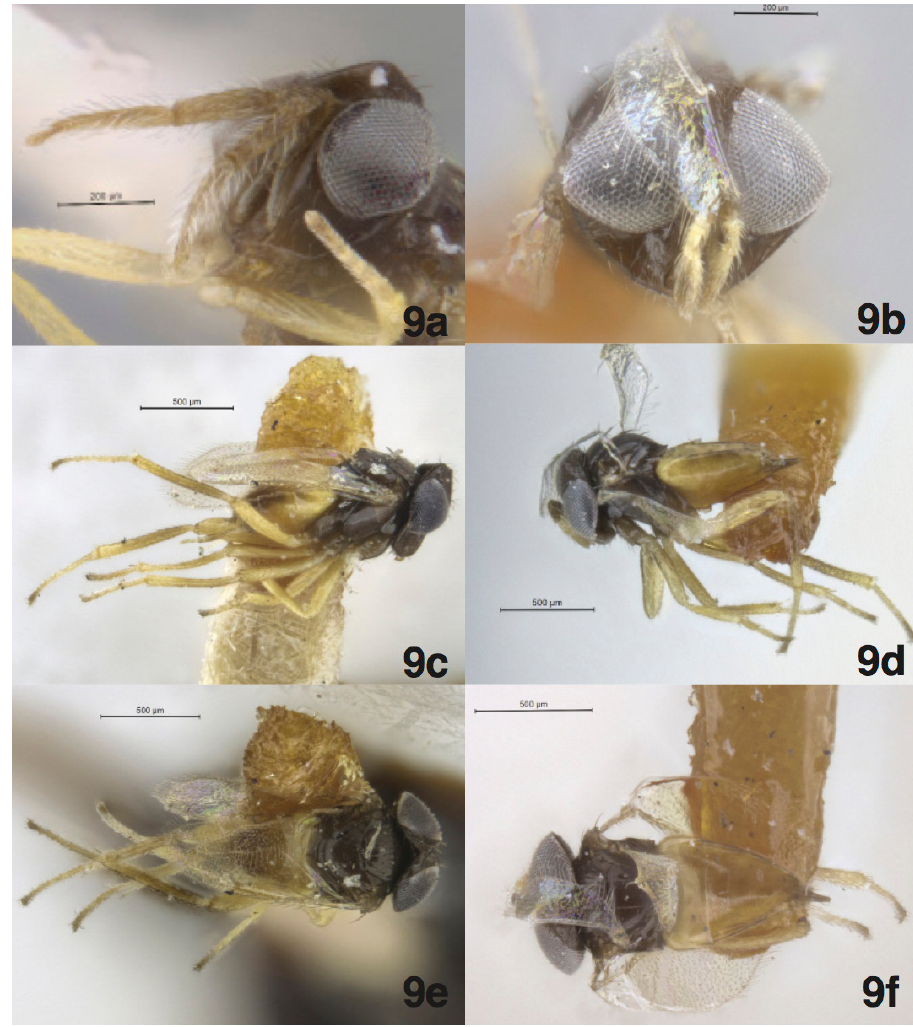
Figure 9. Aphelinus sinensis n.sp., paratypes in 95% ethanol 9a male, antennae and face, anterior view (TAMU-ENTO X0856562) 9b female, antennae and face, anterior view (TAMU-ENTO X0856563) 9c male, habitus, lateral view (TAMU-ENTO X0856562) 9d female, habitus, lateral view (TAMU-ENTO X0856563) 9e male, habitus, ventral view (TAMU-ENTO X0856562) 9f female, habitus, ventral view (TAMU-ENTO